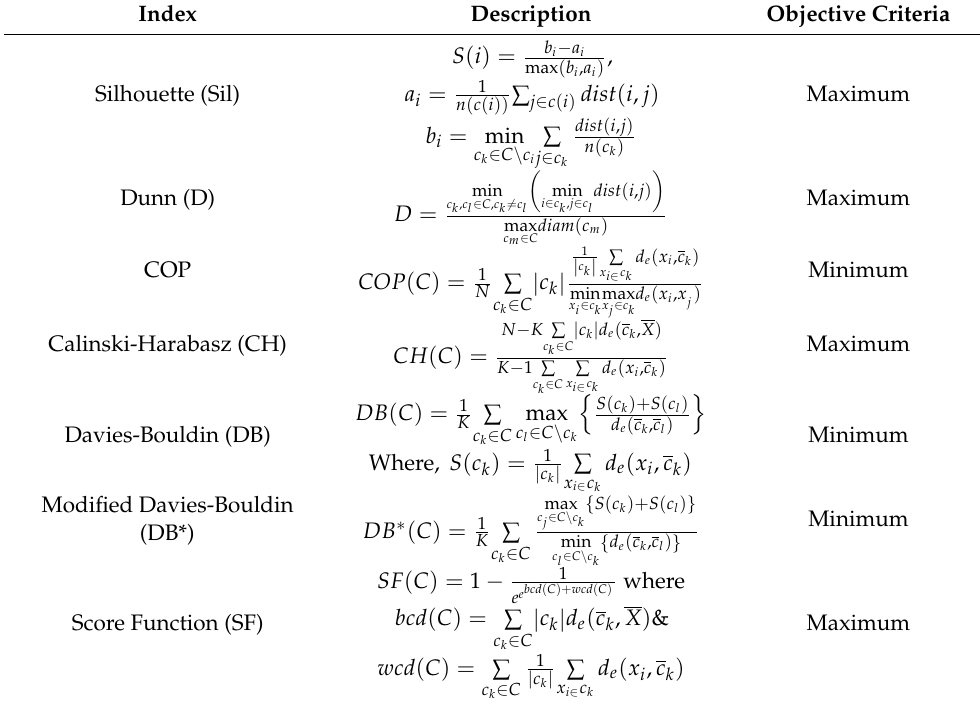
Table 3. Cluster Validity Index